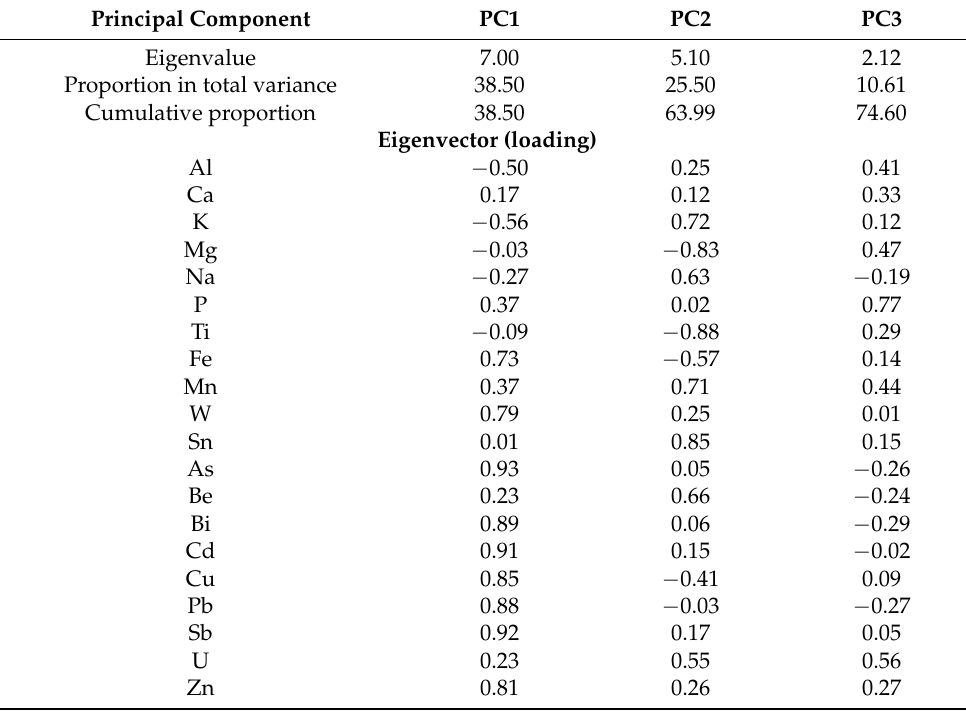
Table 2. Eigenvalues and eigenvectors of the principal